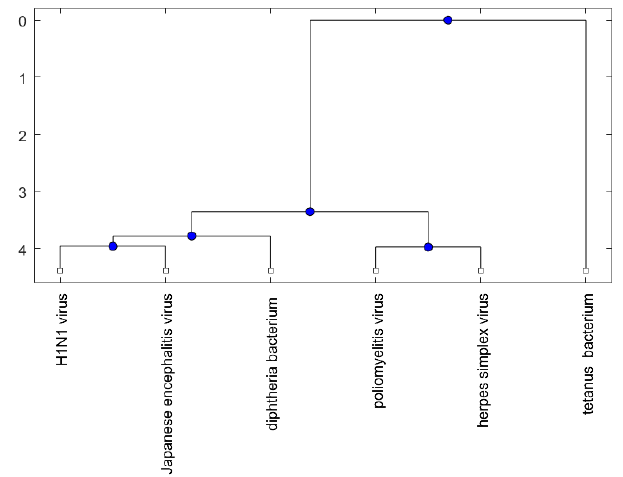
Figure 5. The phylogenetic tree of virus or bacterium based on the alignment score distance and average linkage function.